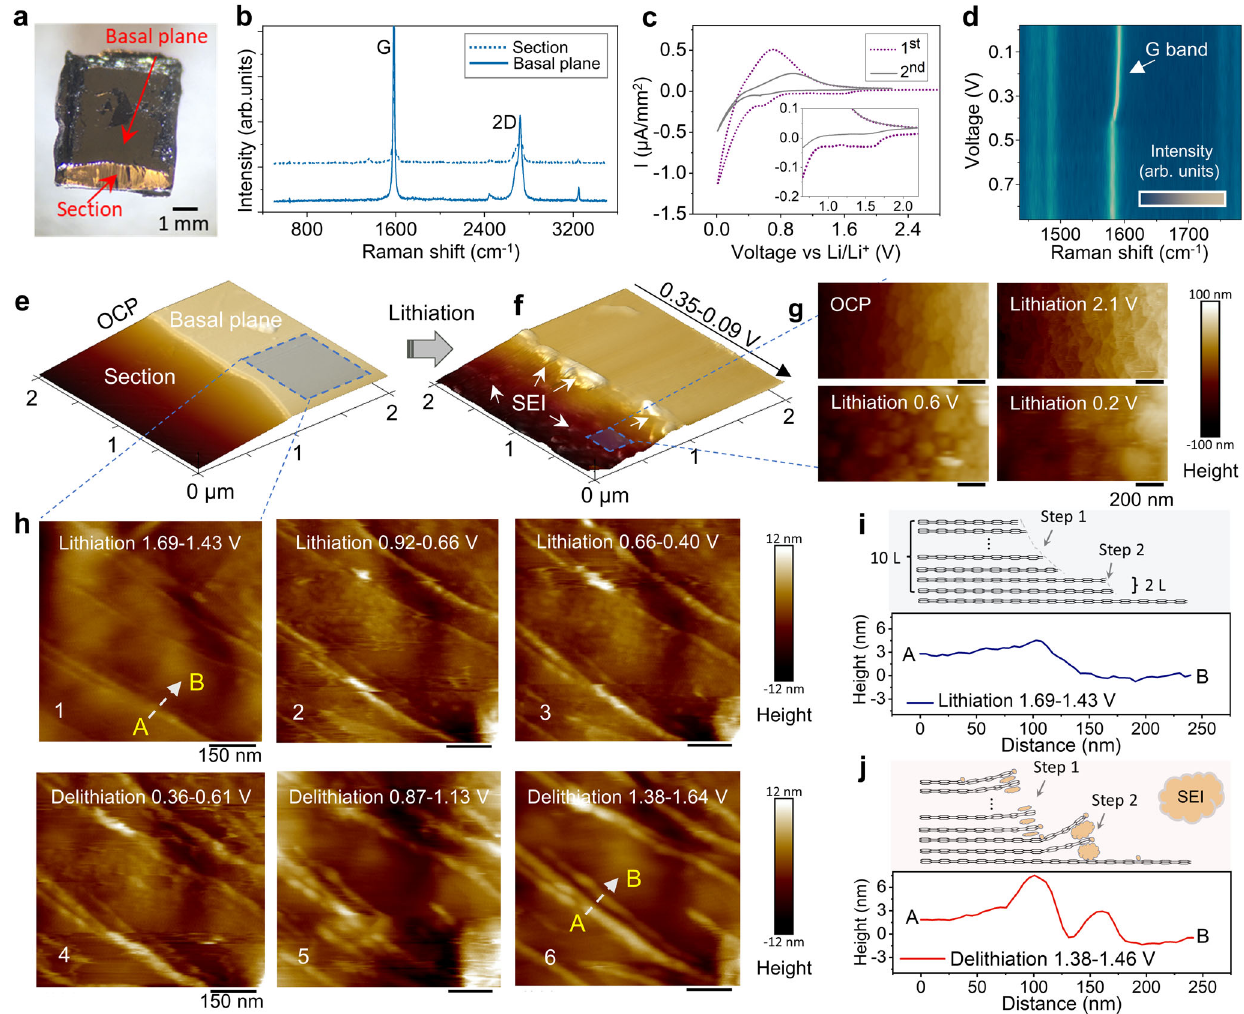
Fig.1|GraphitecrystalmodelsampleandSEIformationontheedgesectionvs basal plane. a Optical image of a cross-section HOPG model sample. b Raman spectra at polished section and basal plane of as-prepared model sample. c First twocyclicvoltammetry(CV)curvesofmodelsample.(0.5mV/sscanrate,1MLiPF section area upon the fi rst lithium intercalation. e – h Dynamic topography